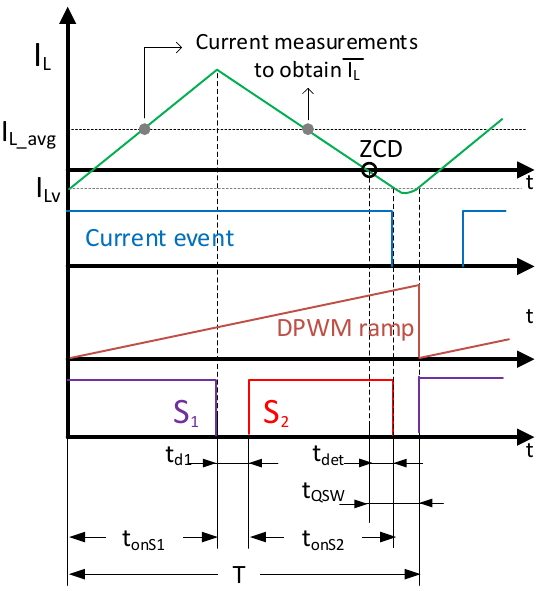
Figure 8. Main waveforms of the event-based DPWM with variable switching frequency implemented for QWS-ZVS operation: I L (green), current event detection signal (blue), DPWM ramp (brown) and gate signals (S 1 in violet, S 2 in red).